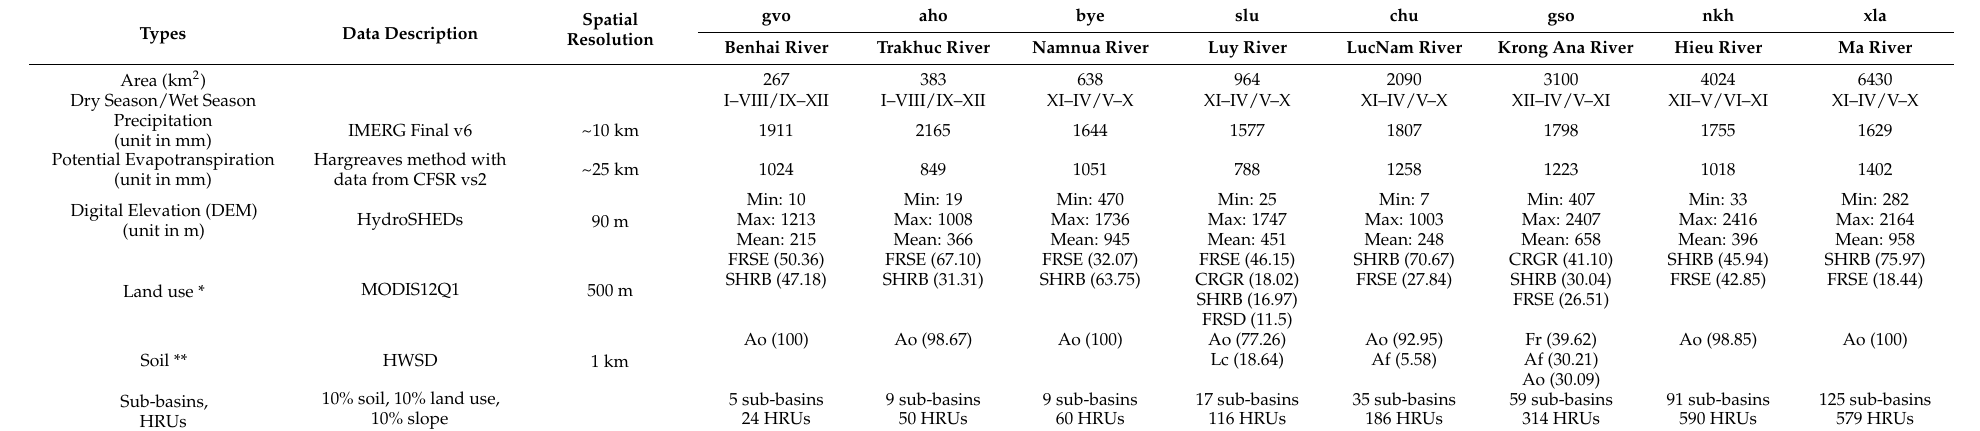
Table A1. Characteristics of climatic conditions and catchment attributes in eight studied catchments. The precipitation and potential evapotranspiration in each catchment are estimated from the calibrated SWAT model for the entire area of that